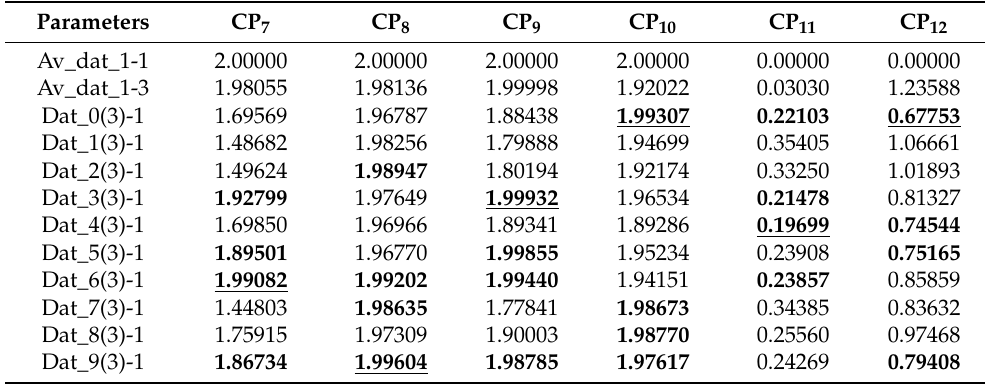
Table 7. Additional correlation parameters for sensors 1–3 that were extracted from complex mo- ments.